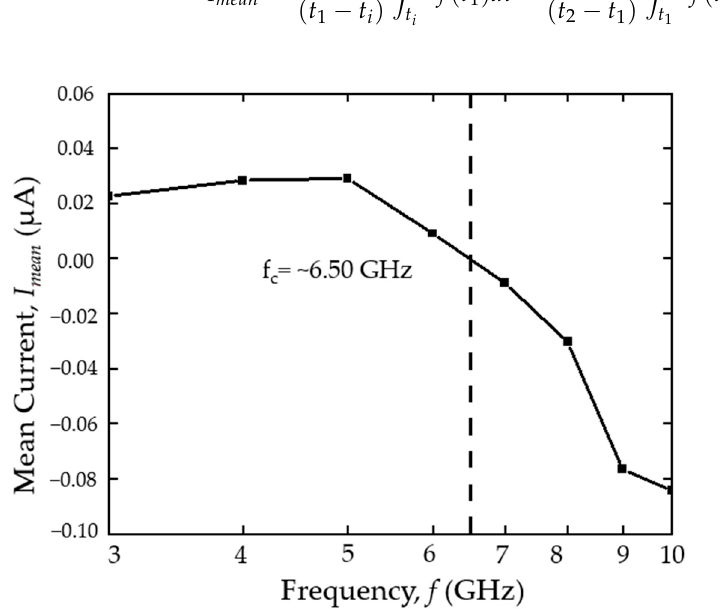
Figure 11. Cutoff frequency and the mean current values in each simulated frequency by using the optimized SSD structure.